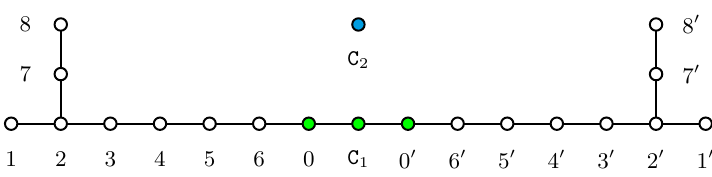
Figure 3. Simplest extended diagram for T 2 compacti(cid:12)cations, reproducing the 44 maximal enhancements of S 1 compacti(cid:12)cations times A 1 . All models have A 2 = 0 and E = E 1 .